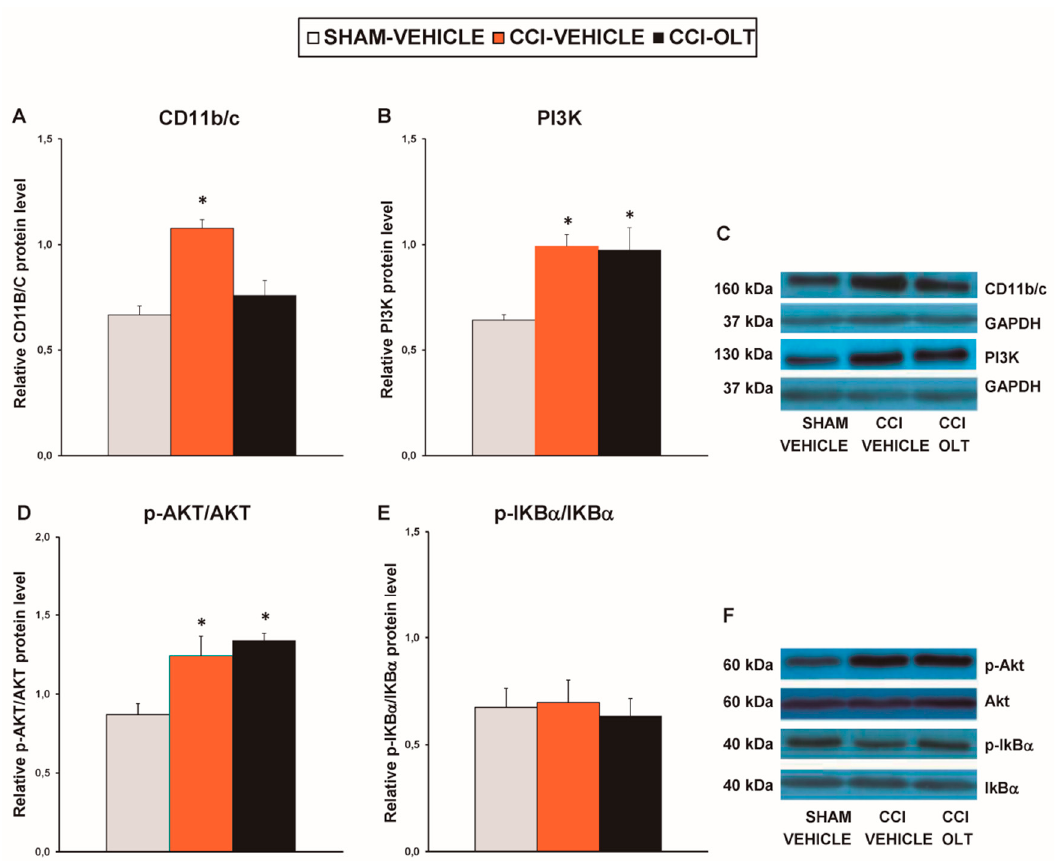
Figure 6. E ff ects of oltipraz on the expression of CD11b / c, PI3K, p-Akt, and p-IkB α in the hippocampus of the CCI-injured mice. The relative protein levels of ( A ) CD11b / c, ( B ) PI3K, ( D ) p-Akt, and ( E ) p-IKB α in the hippocampus of the CCI-injured mice treated with oltipraz (OLT) or vehicle. The sham-operated mice (SHAM) treated with vehicle were used as controls. Representative examples of blots for ( C ) CD11b / c (160 kDa), PI3K (130 kDa), and GAPDH (37 kDa); and ( F ) for p-Akt (60 kDa), Akt (60 kDa), p-IKB α (40 kDa), and IKB α (40 kDa). CD11b / c and PI3K are expressed relative to GAPDH levels whereas phosphorylated proteins are expressed relative to their corresponding total proteins. In all panels, * denotes significant di ff erences vs. sham-operated mice treated with vehicle ( p < 0.05; one-way ANOVA followed by the SNK test). Results are presented as the mean ± SEM; n = 5 samples per experimental group.